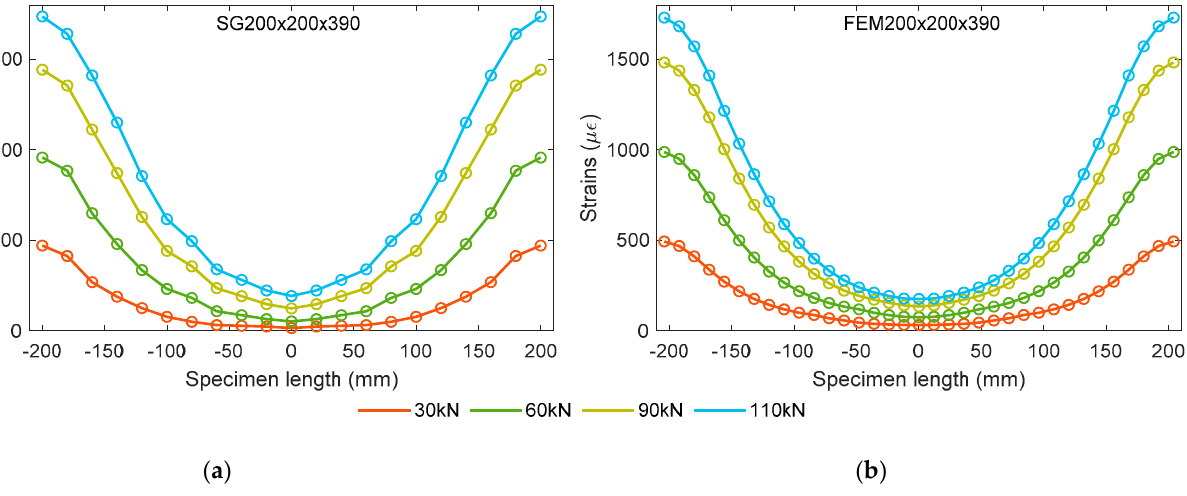
Figure 6. Strain profiles at different load from: ( a ) SG200×200×390 and ( b ) FEM200×200×390. It is seen in Figure 6a that the strain curve at the 30 kN load varies from 15 µε to 471 µε , whereas the strain curve at 110 kN load varies from 192 µε to 1737 µε . Evidently, the strain curve gradients are increasing with the increase in load, as seen in both specimens. It can be directly related to the bond stress ( τ ) as a function of strain gradient through Equation